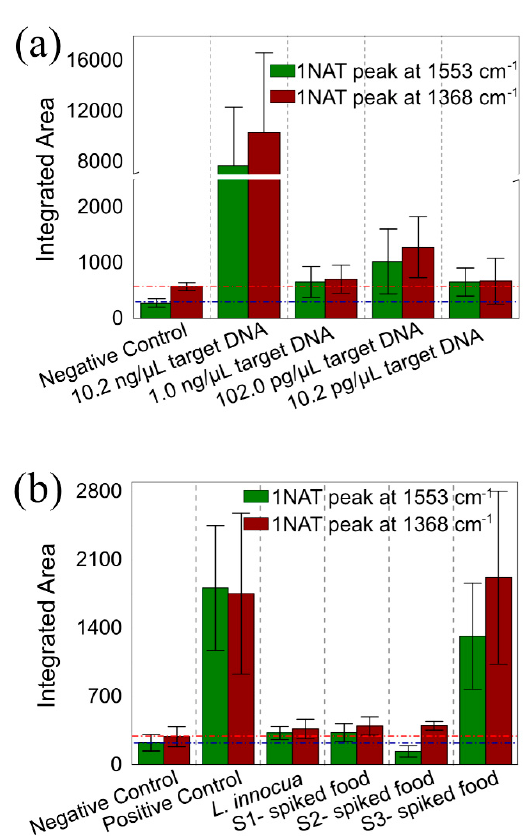
Figure 6. LAMP-on-a-chip SERS assay were performed for L. monocytogenes detection in the conditions presented in ( a ) Figure 5 and ( b ) Figure 7. The bar charts show the integrated area of 1NAT peaks centered at 1553 and 1368 cm − 1 (shaded area in Figures 5 and 7) at ( a ) each of the target DNA concentrations, and these are compared to a negative control sample (i.e., no target DNA present); and ( b ) of the target DNA extracted from UHT milk sample that was inoculated with 10 (S1-spiked food), 90 (S2-spiked food), and 90 × 10 2 (S3-spiked food) CFU of L. monocytogenes , these are compared to a positive control (i.e., 10.2 ng / µ L of target DNA), a negative control (i.e., no target DNA present) and a control sample with DNA from L. innocua instead of the target DNA. Integrated areas were obtained by acquiring 6–13 SERS spectra inside the microdroplets and the error bars represent one standard error of the mean (SEM). The dashed lines give visual clarification of the integrated areas of the negative